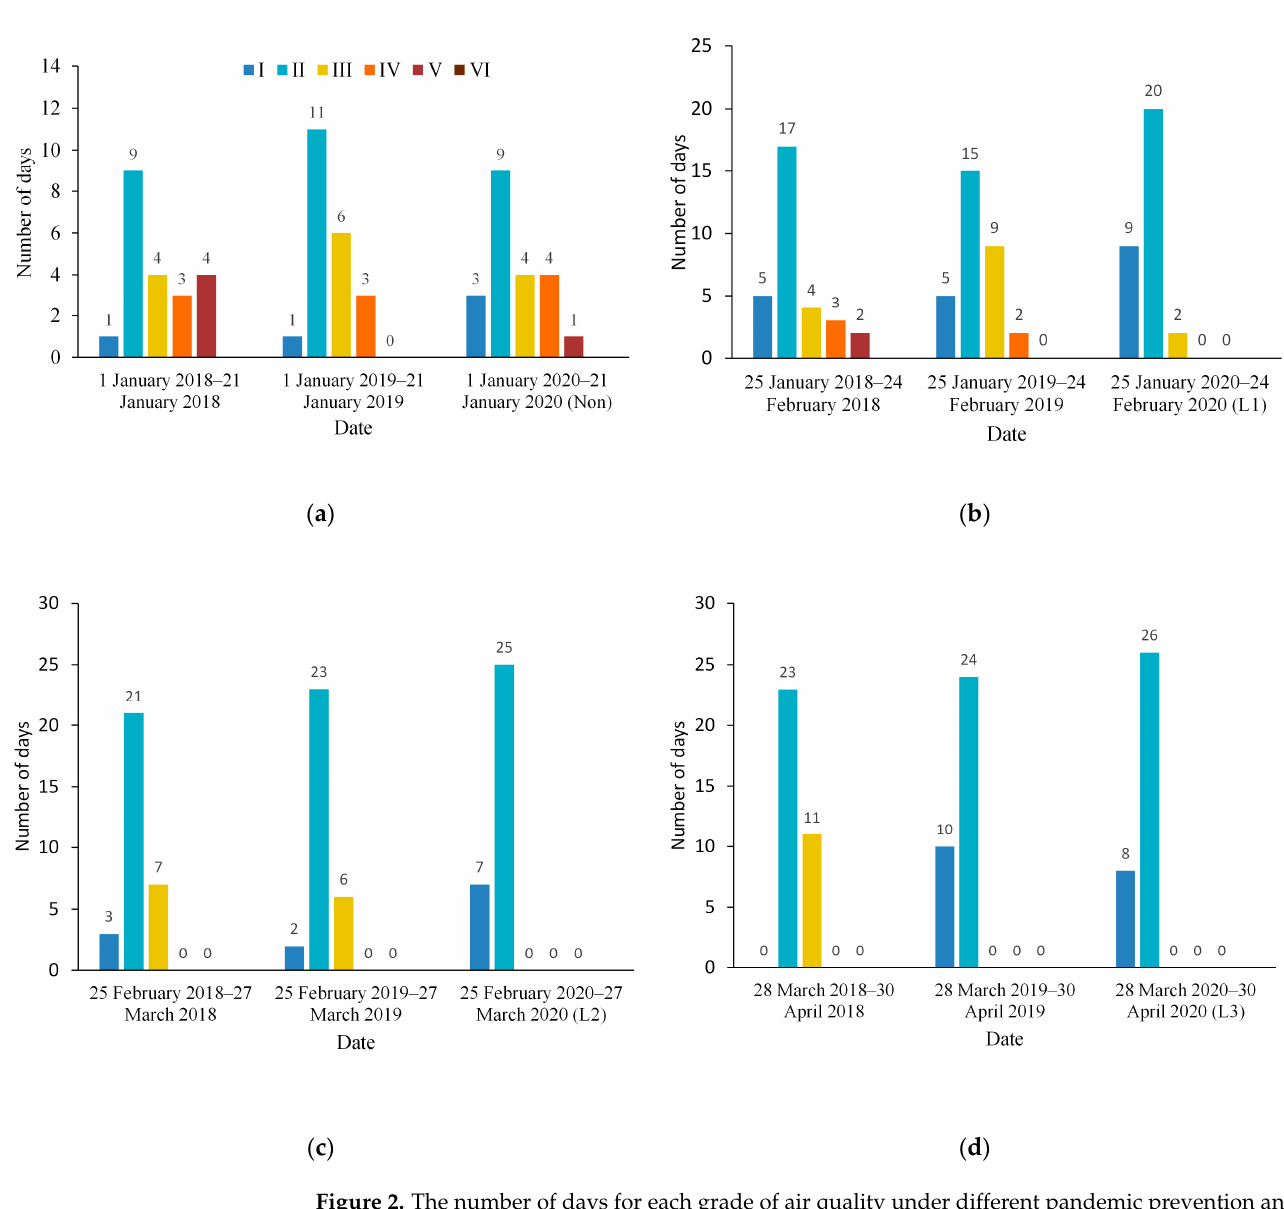
Figure 2. The number of days for each grade of air quality under different pandemic prevention and control levels in Jiangsu Province (( a ), Non; ( b ), L1; ( c ), L2; ( d ), L3). Table 2. Significance levels for periods with different levels of PPC measures by Student’s t -test ( α =